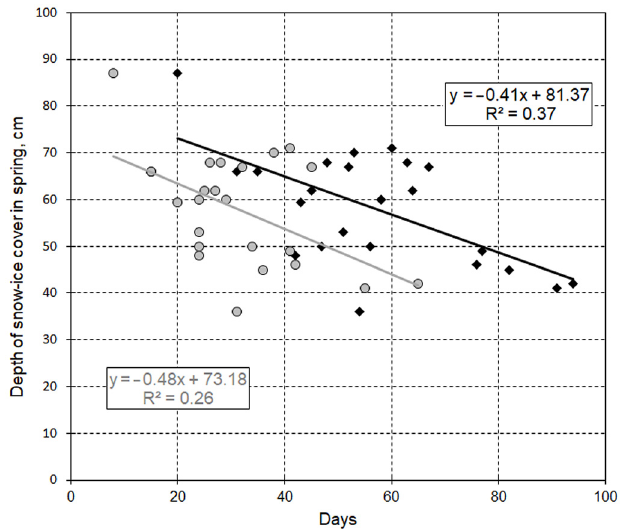
Figure 4. The thickness of the snow-ice cover of Lake Vendyurskoe in spring in 1995–2000, 2002–2018, and 2020 as a function of the number of days with positive air temperature in November–April (Days_T AIR > 0, black diamonds), and the number of days with liquid or mixed precipitation (Days_P LM , grey circles) in the same period. Bold lines are the regression lines.